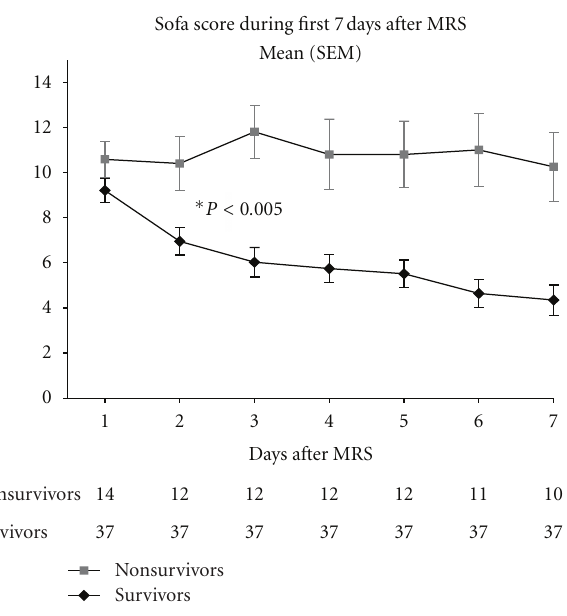
Figure 2: Sequential organ failure assessment (SOFA score) significantly decreases after the third day in ARDS